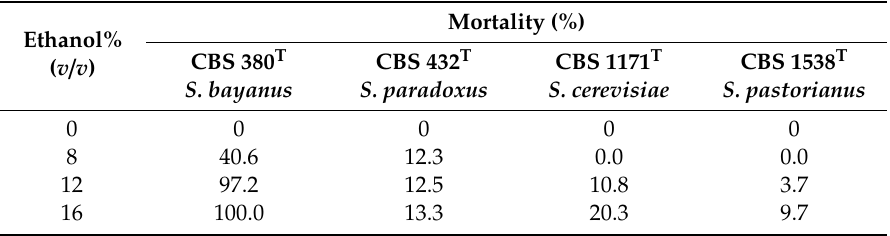
Table 2. Mortality (%) induced by increasing ethanol concentrations on the four strains from Saccharomyces sensu stricto